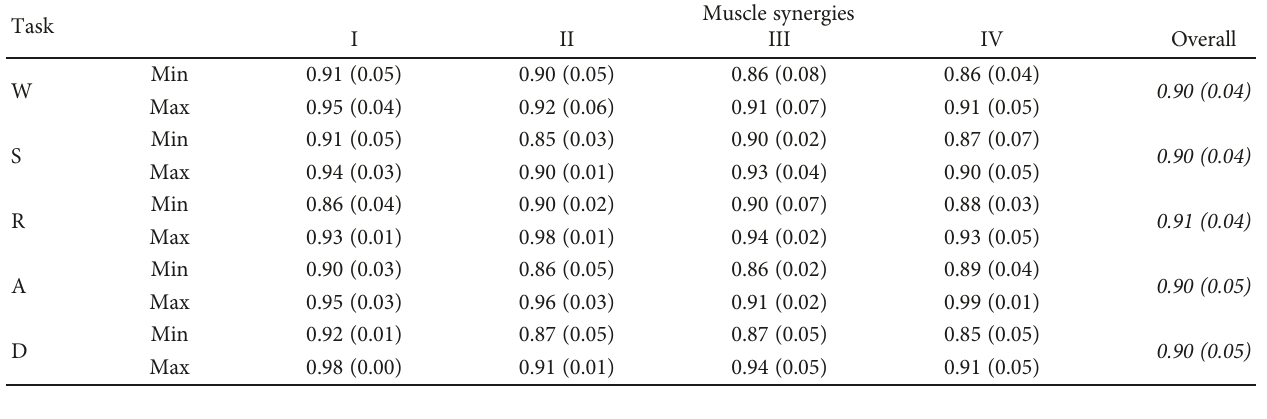
Table 8: Maximum and minimum and relative standard deviation (SD) of the WB R 2 related to each task. The overall means evaluated considering all the synergies together are reported in italic.